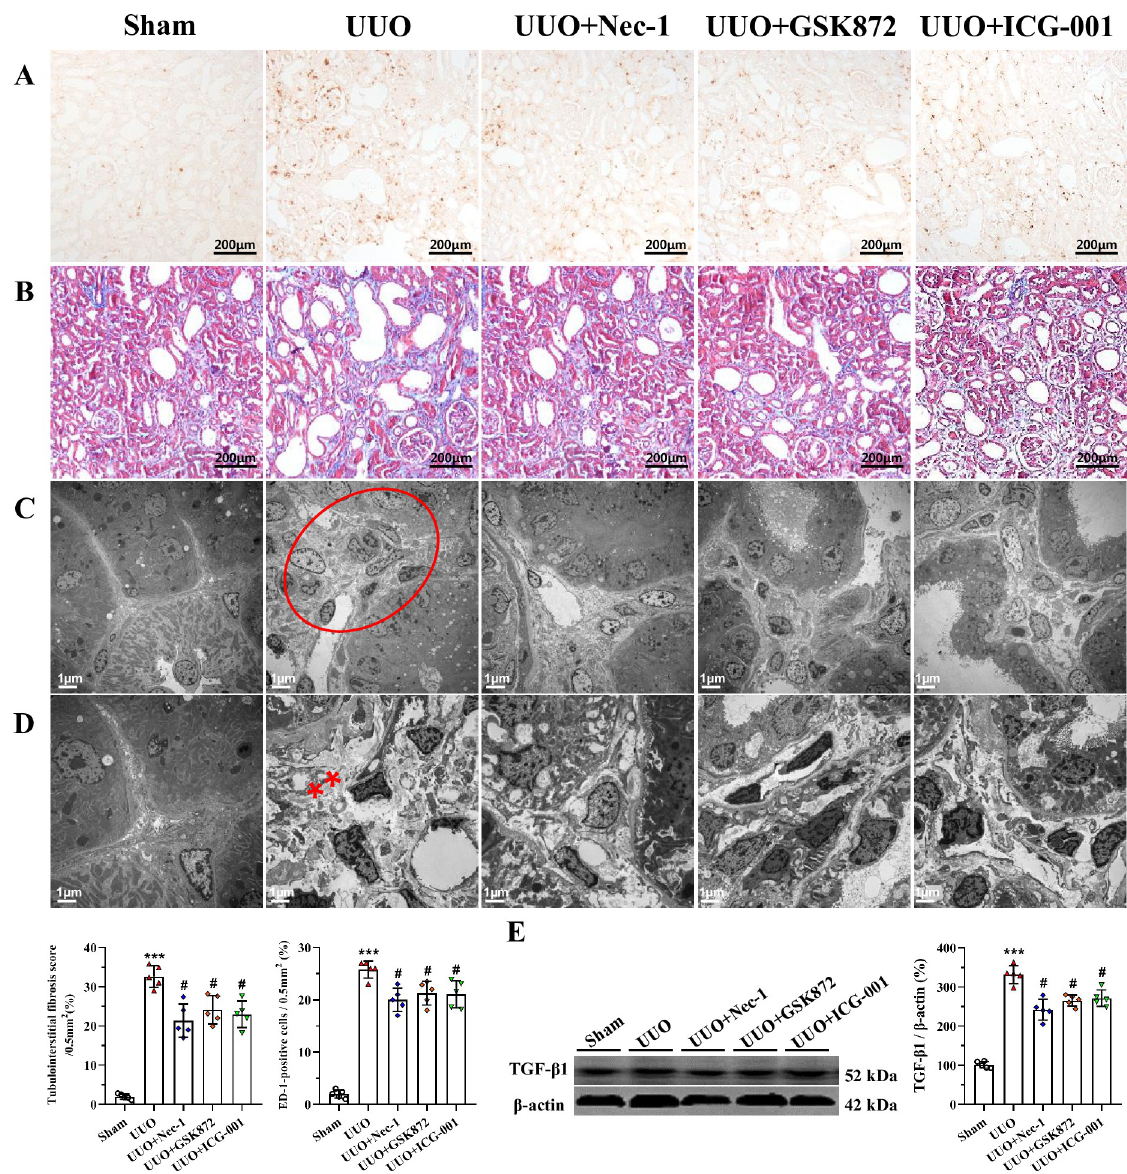
Fig 3. Representative photomicrographs of immunohistochemistry (A), Masson trichrome staining (B), transmission electron microscopy (C and D), and immunoblotting analysis (E). Induction of UUO resulted in massive inflammatory cell infiltration (circle) and significant interstitial collagen fiber deposition (starlikes) within the tubulointerstitium. ��� P < 0.01 vs. sham; # P < 0.05 vs. UUO.